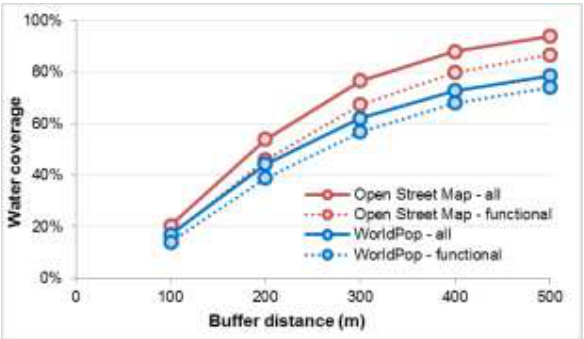
Figure 4: Comparison of water coverage calculated using all and only functional water sources and two population data